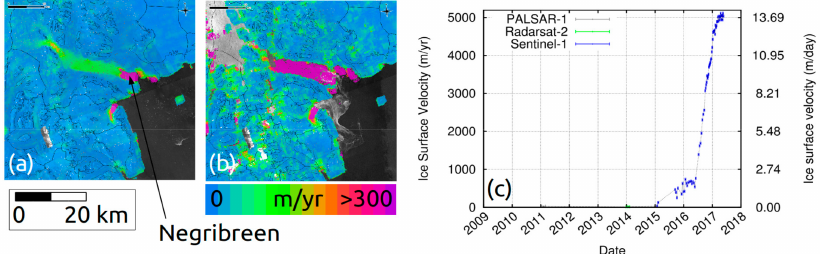
Figure 8. Ice surface velocity maps for Negribreen on Spitsbergen (Svalbard) from Sentinel-1 data of the time periods 01/10/2015 to 13/10/2015 ( a ) and 31/10/2016 to 12/11/2016 ( b ) and time-series of velocity close to the front from 2011 to 2017 ( c ). The arrow points to the location used for the time